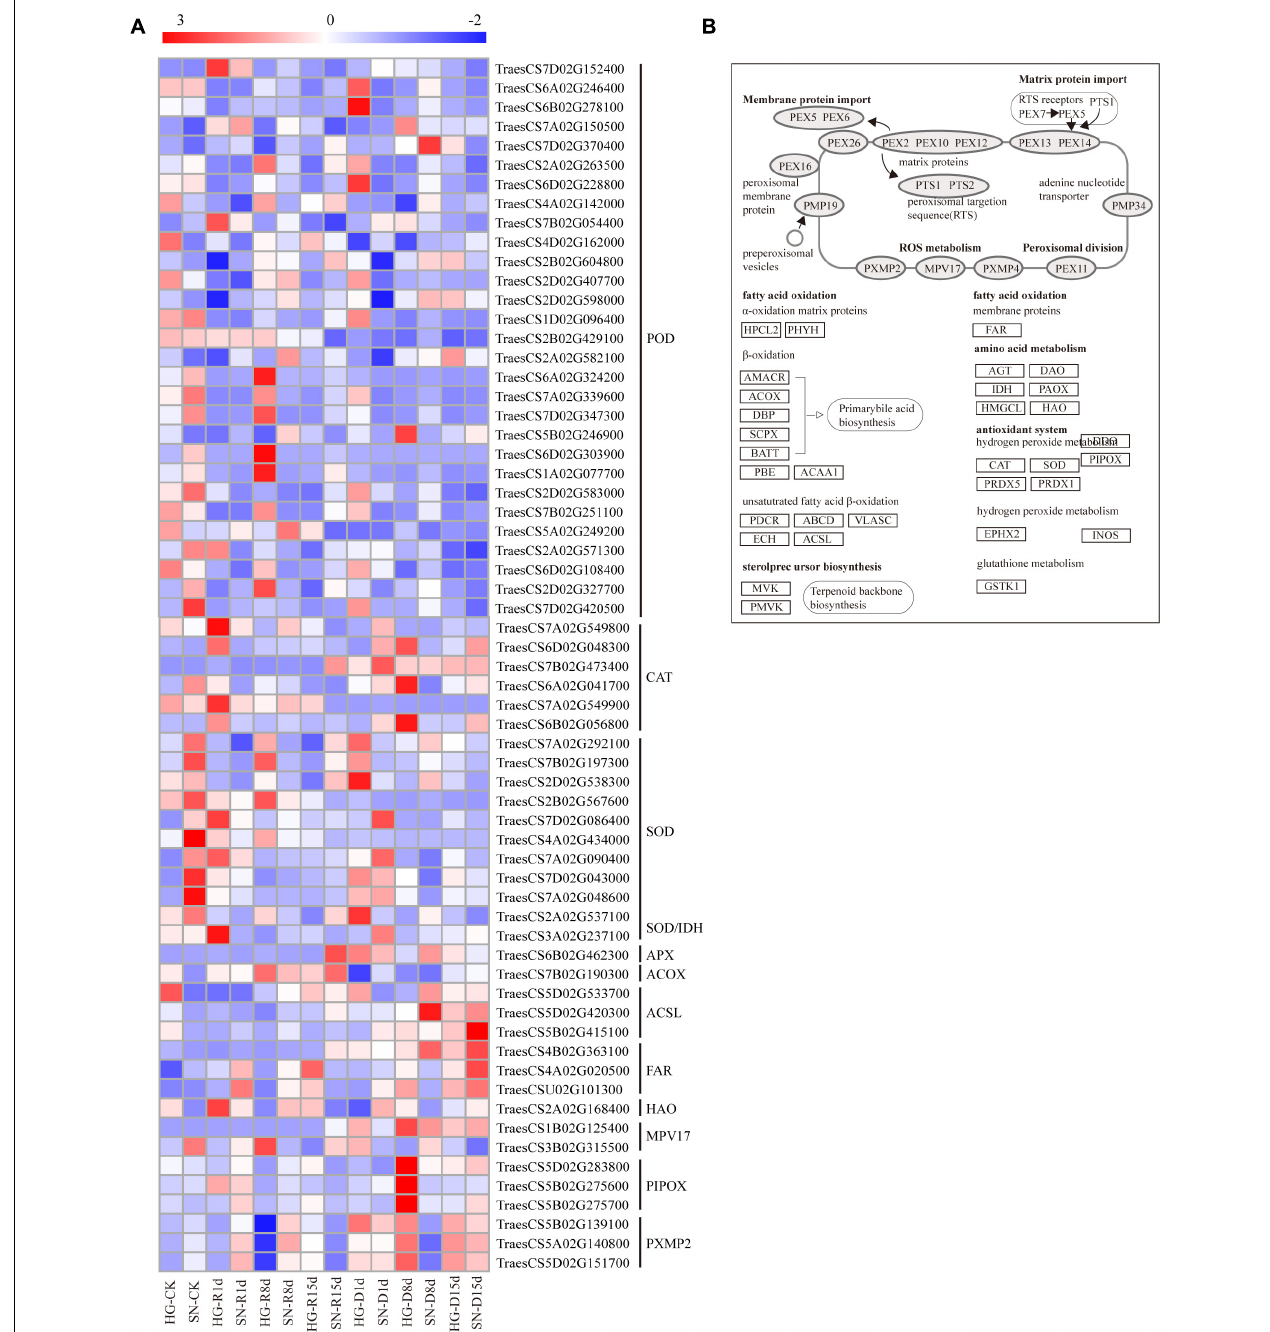
FIGURE 8 | Expression profiles of DEGs involved in ROS-related pathways. The expression levels of transcripts (A) in antioxidative and biosynthetic pathways (B) were generated using their FPKM values.